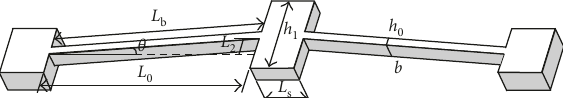
Figure 1: Schematic diagram of a V-shaped electrothermal